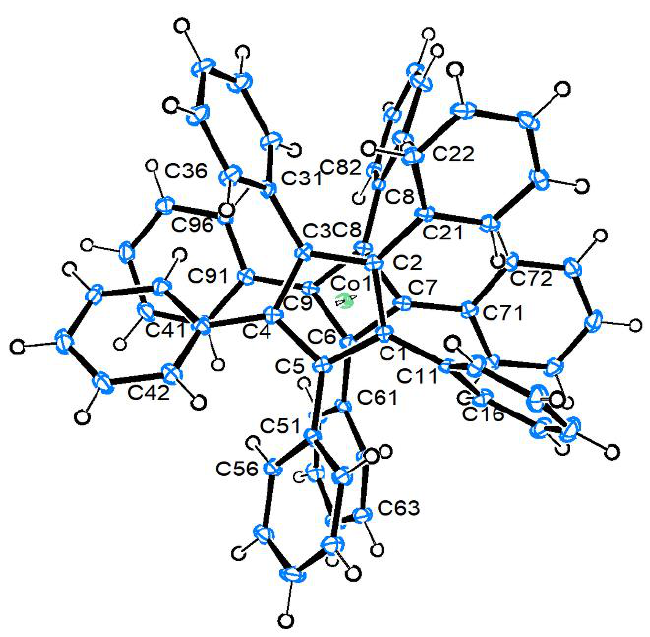
Figure 1. Top view of compound 1 (ORTEP3, thermal ellipsoids at the 30% probability level). To evaluate the importance of these parameters, a comparison must be made with other co-ordination compounds with [C 5 Ph 5 ] and [C 4 Ph 4 ]. A search in the Cambridge Structural Database (accessed on 2 November 2022) shows 125 entries for [M(C 5 Ph 5 )] fragments and 220 entries for [M(C 4 Ph 4 )] fragments. Of these, five contain a [Co(C 5 Ph 5 )] core (GAHRUC [23], NICDIM [24], POHXAL [25], REXNEO [26], TUPQAW [27]), and four contain a [Co(C 4 Ph 4 )(C 5 R 5 )] (R (cid:54) = H) core (MEYQAI, MEYQOW [28], NEVDAT [29], UZUQUE [22]). Although many structures have two C 5 Ph 5 rings (including [Co(C 5 Ph 5 ) 2 ] + , POHXAL), none has exclusively two C 4 Ph 4 rings. There is only one structure of the [Co(C 4 Ph 4 )(C 5 R 5 )] type with one phenyl substituent in the cyclopentadienyl ring (WEB- MUL10, [14]). We decided to use the mentioned C 5 Ph 5 structures (except for REXNEO, which is a binuclear compound) and the C 4 Ph 4 structures NEVDAT, UZUQUE, WEB- MUL10 and [Co(C 5 H 5 )(C 4 Ph 4 )] (CPBUCO01, [30] for comparison with compound 1 . The relevant data are presented in Table